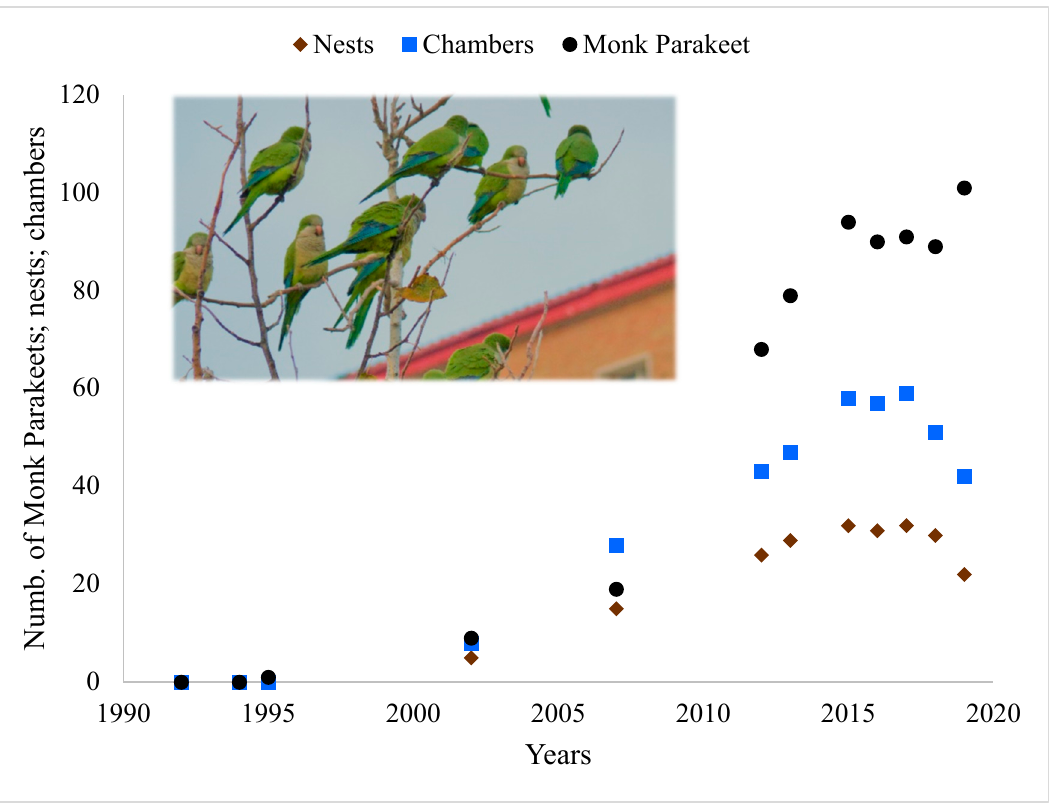
Figure 2. Estimated Monk Parakeet population size from 1992 to 2019, measured in terms of the number of observed parakeets, nests and nest chambers. Table 1. Nesting substrates used by the Monk Parakeet in the study area in